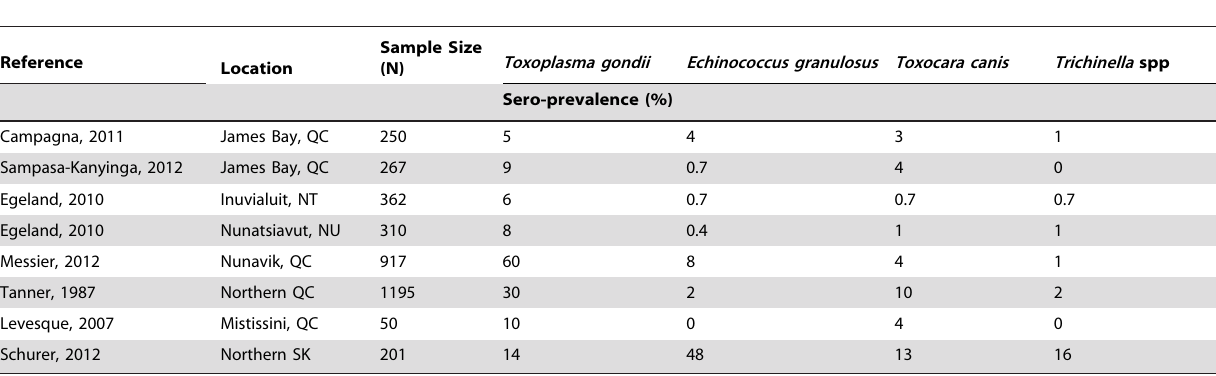
Table 2. Sero-surveillance for Echinococcus granulosus, Trichinella, Toxocara canis and Toxoplasma gondii in northern Indigenous regions (Canada)